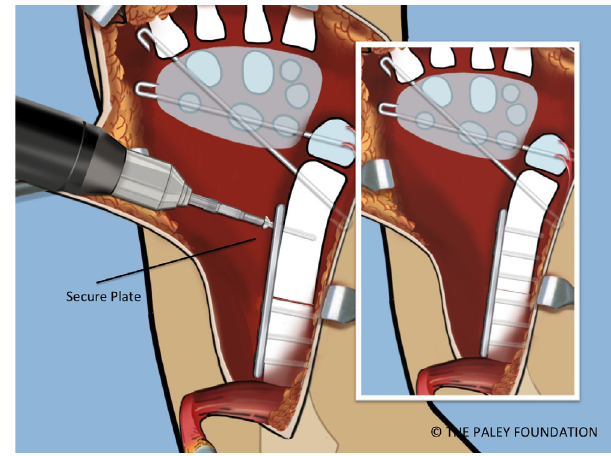
Figure 21. Fix the distal ulna to the plate. Adjust the rotation so that the plane of the hand and the plane of the elbow motion are the same. Stated differently, the lateral the profile view is a lateral of the elbow with an AP of the hand.